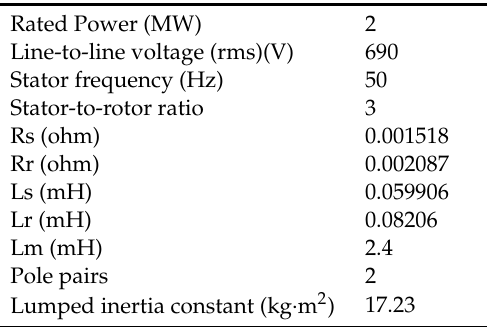
Table 1. DFIG parameters.